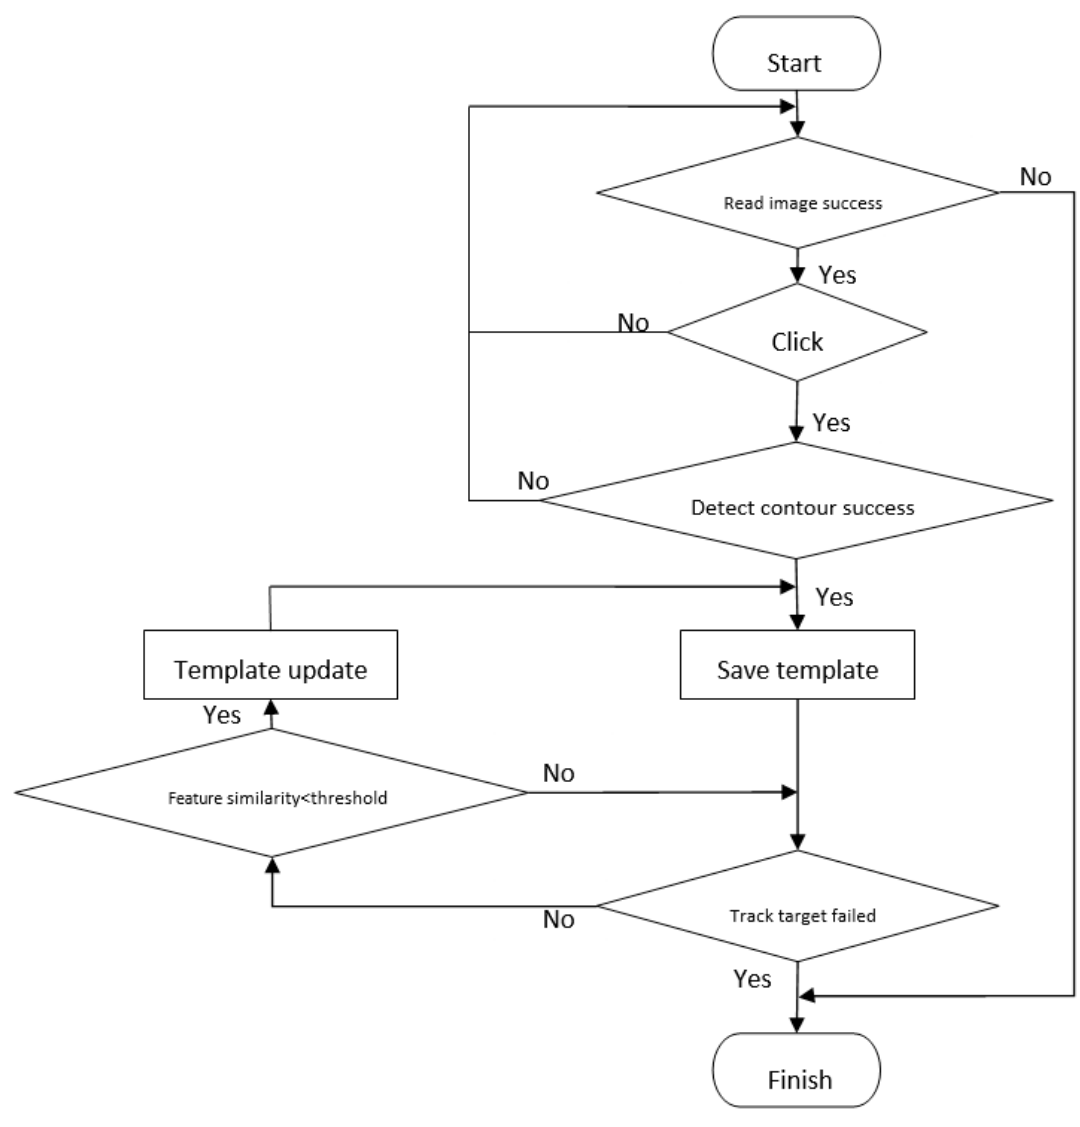
Figure 3. Flowchart of whole system.